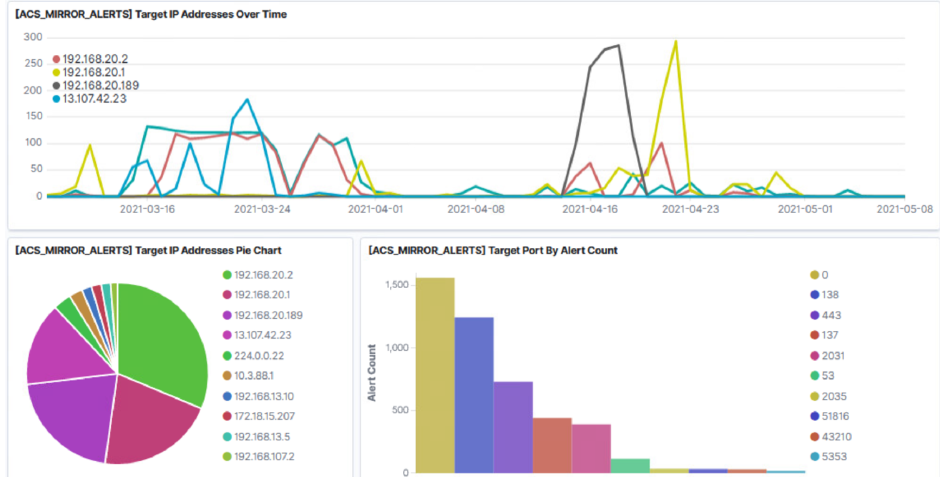
Figure 12. Alerts Dashboard—Target IP and Ports visualizations. Note that IPs have been obfuscated for security